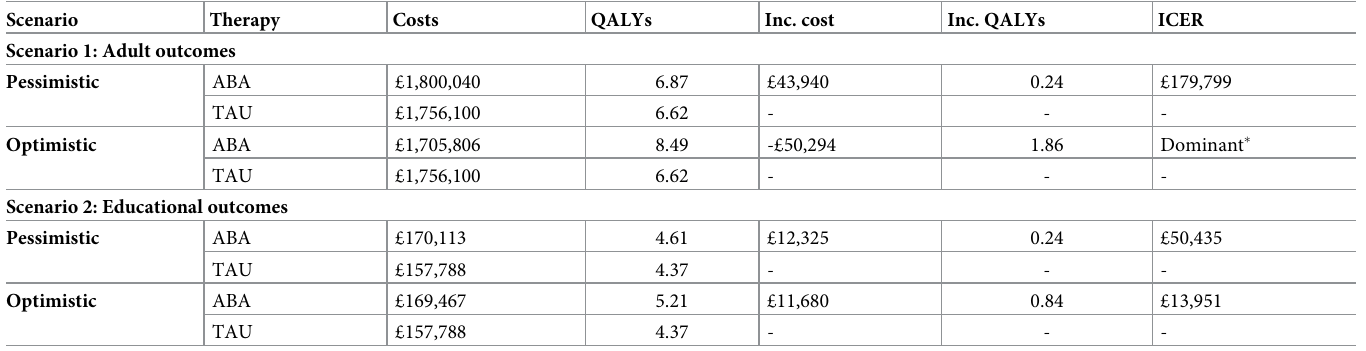
Table 3. Scenario analysis results: Public sector perspective.